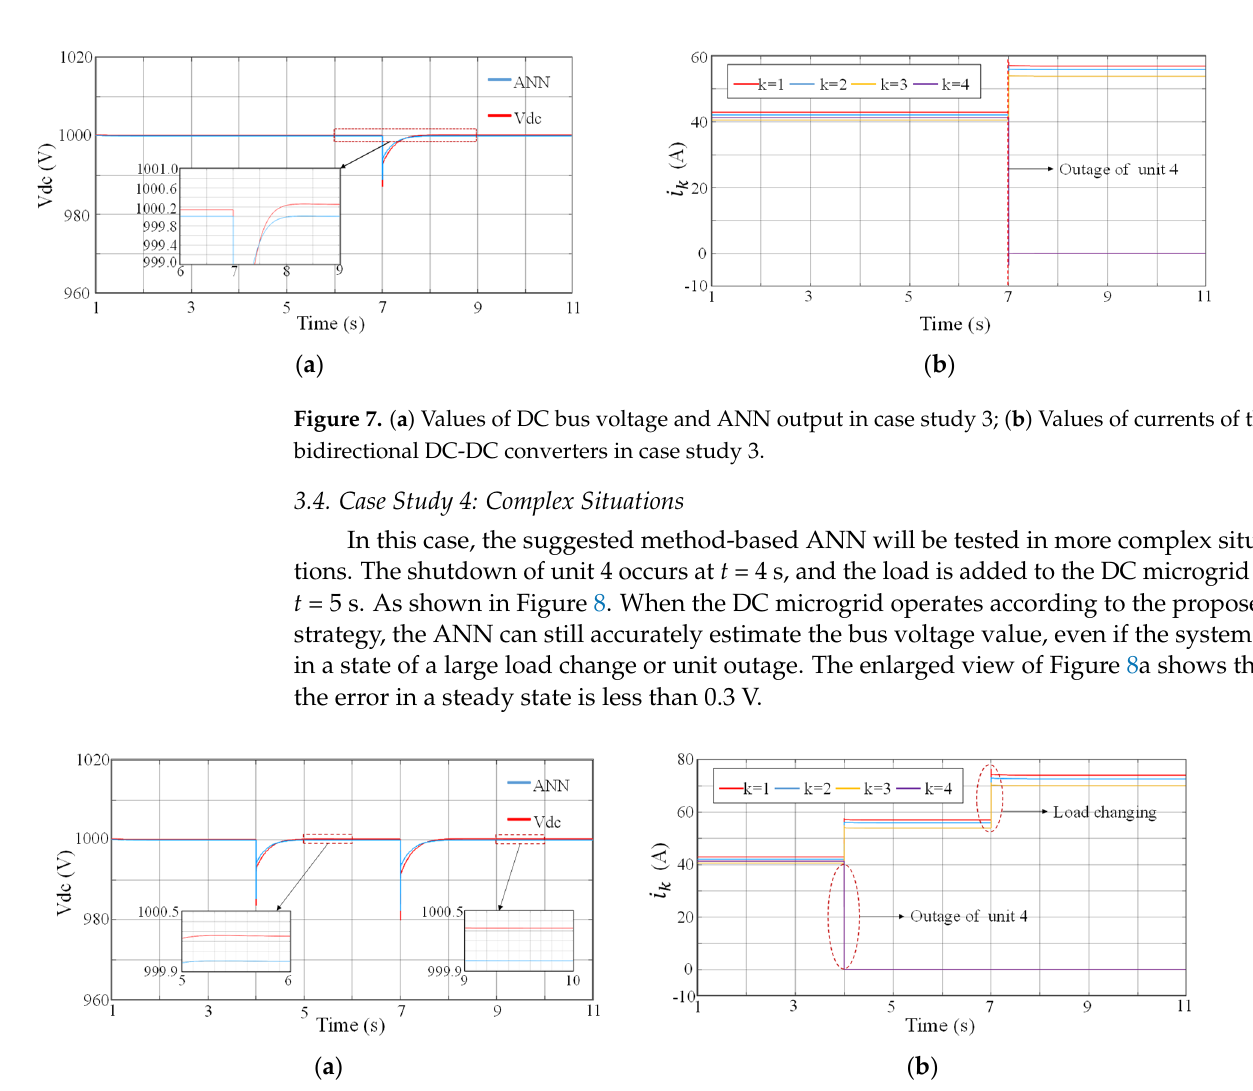
Figure 9. Values of DC bus voltage and ANN output in case study 5.